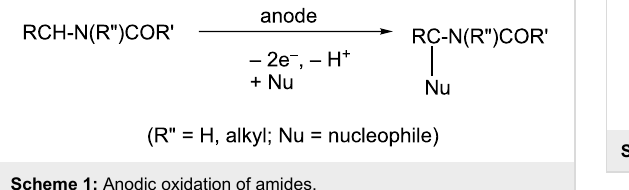
Scheme 1: Anodic oxidation of amides.